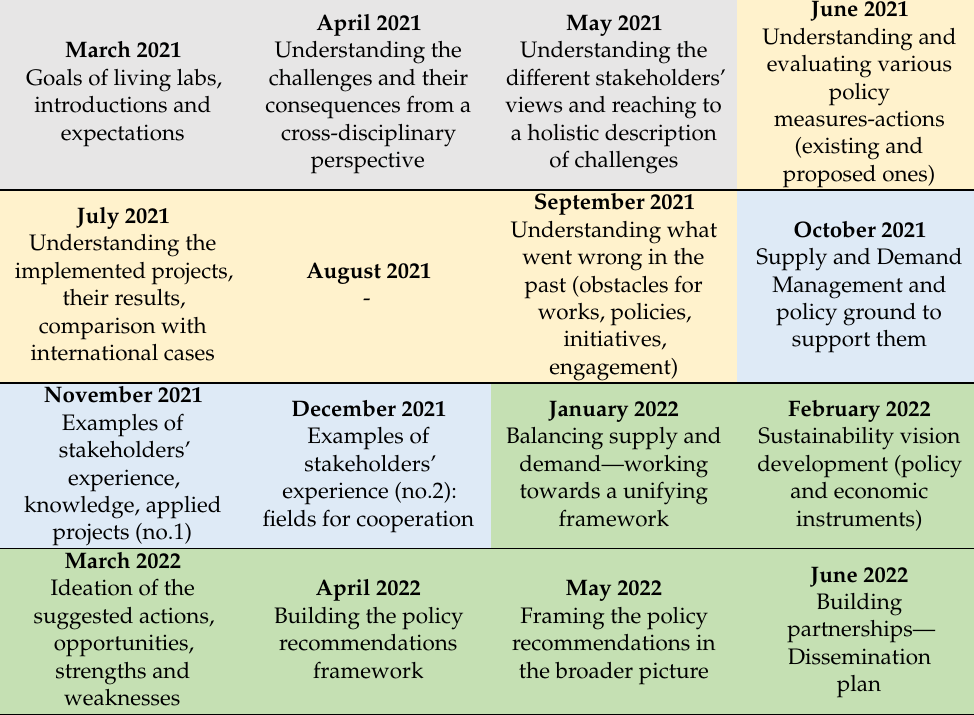
Table 1. Timeline of the Living Labs’ workshop structure (Adapted from